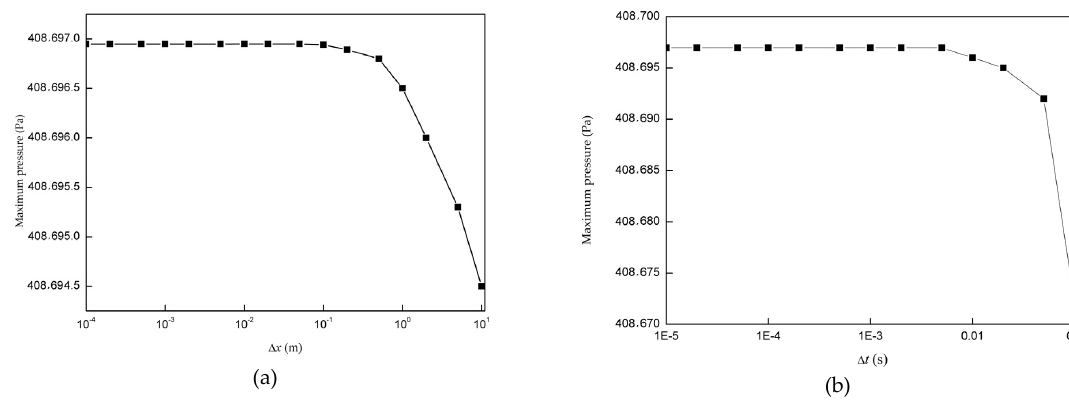
Figure 8. Verification of mesh independent.( a ): verification of Δ x, ( b ): verification of Δ t